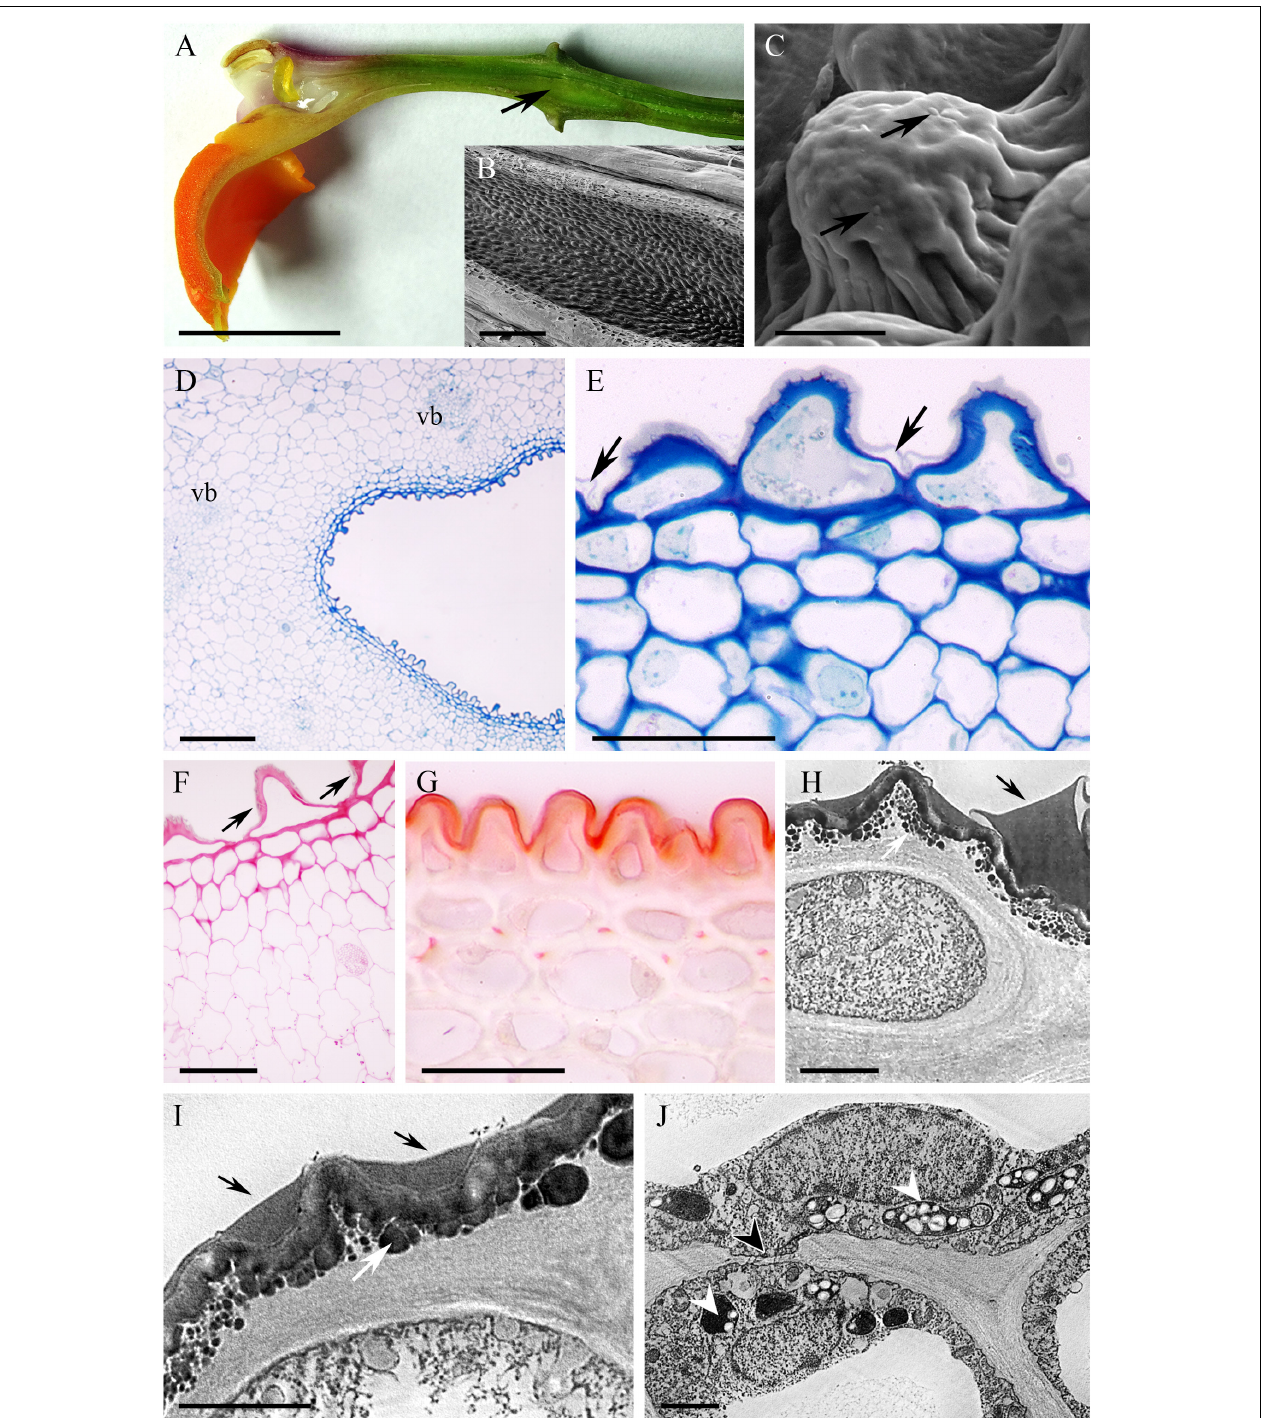
FIGURE 9 | Epidendrum pseudepidendrum . (A) Longitudinal section of flower, cuniculus indicated by arrow. (B) Papillose epidermal cells lining cuniculus. (C) Detail of epidermal cell with cuticular blisters (arrows). (D) Epidermis and parenchyma with vascular bundles enclosing cuniculus (MB/AII). (E) Detail of epidermis and subepidermal parenchyma of cuniculus. Note secreted material beneath cuticle (arrows). (F) PAS reaction stains cell walls and starch in ground parenchyma cells. Surface material accumulates between cuticular ridges (arrows). (G) Sudan III stains cuticle and intercellular material. (H) Epidermal cell with surface secretion (arrow). (I) Detail of epidermal cell wall with subcuticular globular material (white arrow) and surface secretion (black arrows). Secretory vesicles fusing with plasmalemma are also visible. (J) Parenchyma cell with plastids containing an electron-dense stroma and starch grains (arrowheads). A primary pit-field with plasmodesmata marked with arrowhead. Scale bars: A = 1 cm; B,D = 200 µ m; C = 10 µ m; E,G = 40 µ m; F = 50 µ m; H,J = 2 µ m.